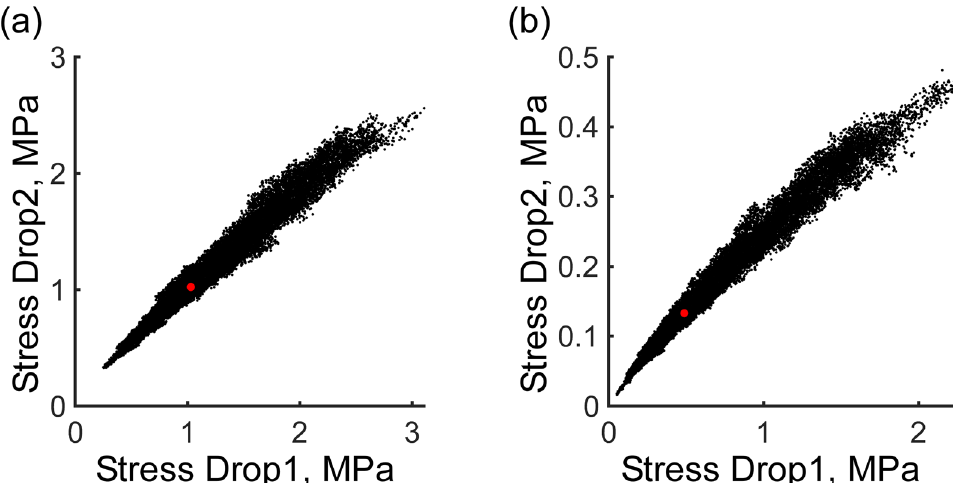
Fig. 7 Sampling distribution of stress drop with a synthetic data and b observational data (7th event in Table 1). The horizontal axis indicates stress drop estimated from large earthquakes, and the vertical axis indicates stress drop estimated from small